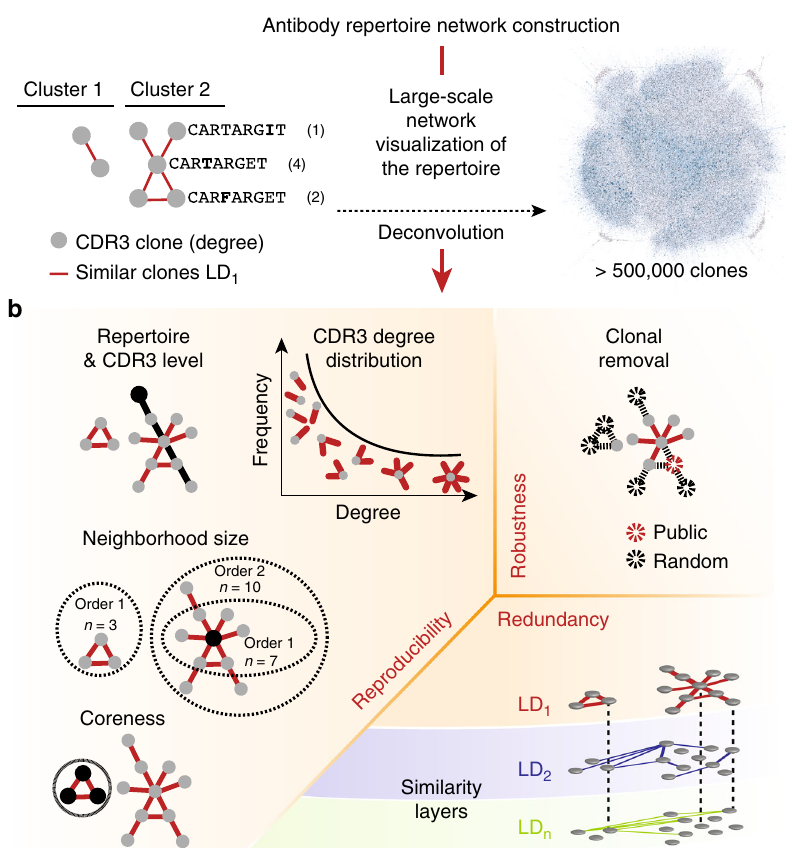
Fig. 1 Large-scale network analysis reveals the architecture of antibody repertoires and its three fundamental principles. a Large-scale networks (>500,000 nodes) of antibody repertoires were constructed from the Levenshtein distance (LD, edit string distance) matrix of CDR3 clonal sequences (a.a) using a custom high-performance computing platform (see Methods). Networks represent antibody repertoires of similar CDR3 nodes connected by edges when amino acid CDR3 sequences differ by a predetermined LD. All clones of a repertoire connected at a given LD form a similarity layer (LD n ). b Deconvolution of the complexity of antibody repertoire architecture was performed by quantifying (i) its reproducibility through global and clonal (local) properties or features, (ii) robustness to clonal removal and (iii) redundancy across its similarity layers in the sequence space (Supplementary Fig.